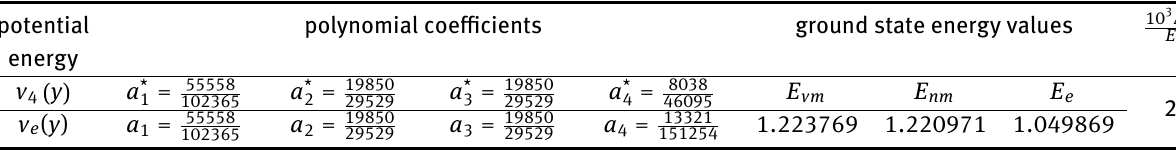
Table 4: Physical parameters for the potential energy v 4 ( y ) = y + y 2 + y 3 + y 4 + y 5 + y 6